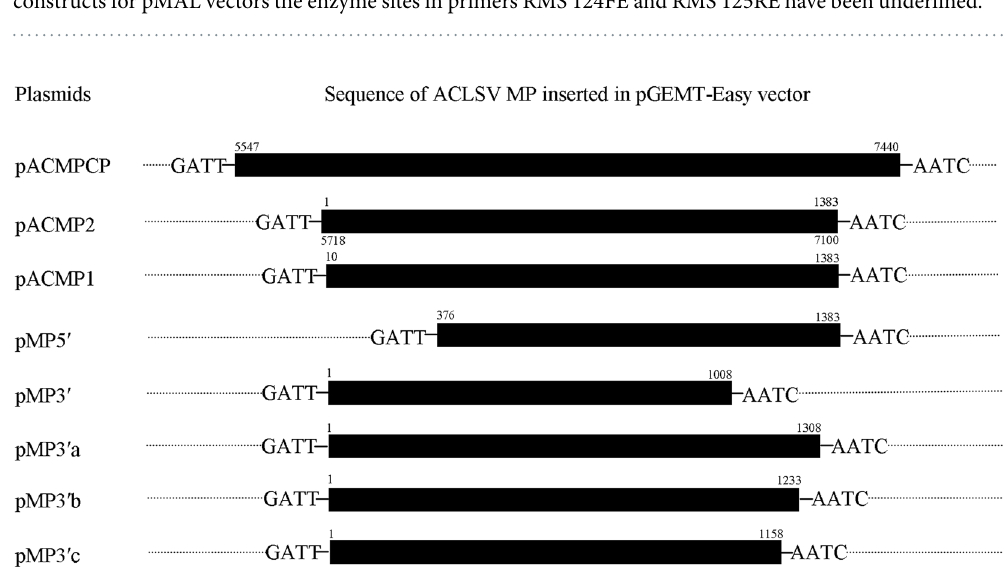
Figure 5. Different sequences of ACLSV genome used to clone ACLSV MP and different truncated mutants of ACLSV MP . Solid black rectangles represent the ACLSV sequences inserted in pGEMT-Easy vector. GATT, AATC and dots represent the vector sequences. pACMPCP contains genomic sequence of ACLSV spanning from 5547–7440 nt’s which contains full-length ACLSV MP and partial CP. pACMP2 is full-length ACLSV MP gene (1383 nt’s), pACMP1 contains ACLSV MP devoid of first nine nucleotides. pMP5 ′ is 5 ′ -end truncated construct which lacks first 375 nt’s, pMP3 ′ lacks 375 nt’s from the 3 ′ -end. pMP3 ′ a , pMP3 ′ b and pMP3 ′ c contain 1–1308 nt’s, 1–1233 nt’s and 1–1158 nt’s of ACLSV MP